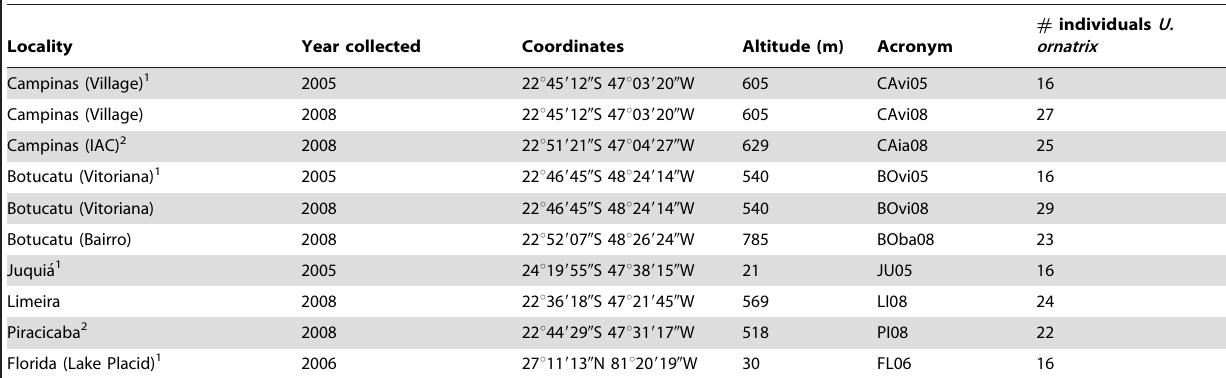
Table 1. Populations used in the